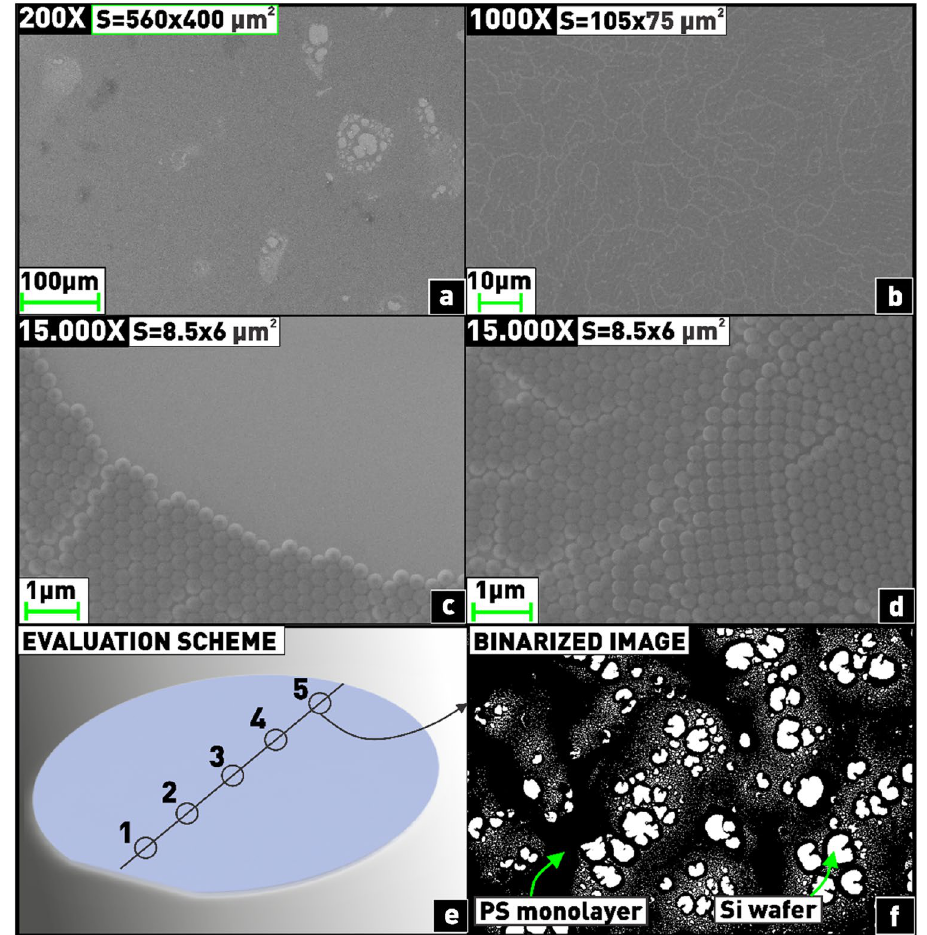
Figure 2. Methodology for estimating nanosphere coverage area: (a–d) demonstration of differences in the results obtained at different magnifications; (e) five-point measurement scheme for coverage area; (f) binarization of the image for coverage area